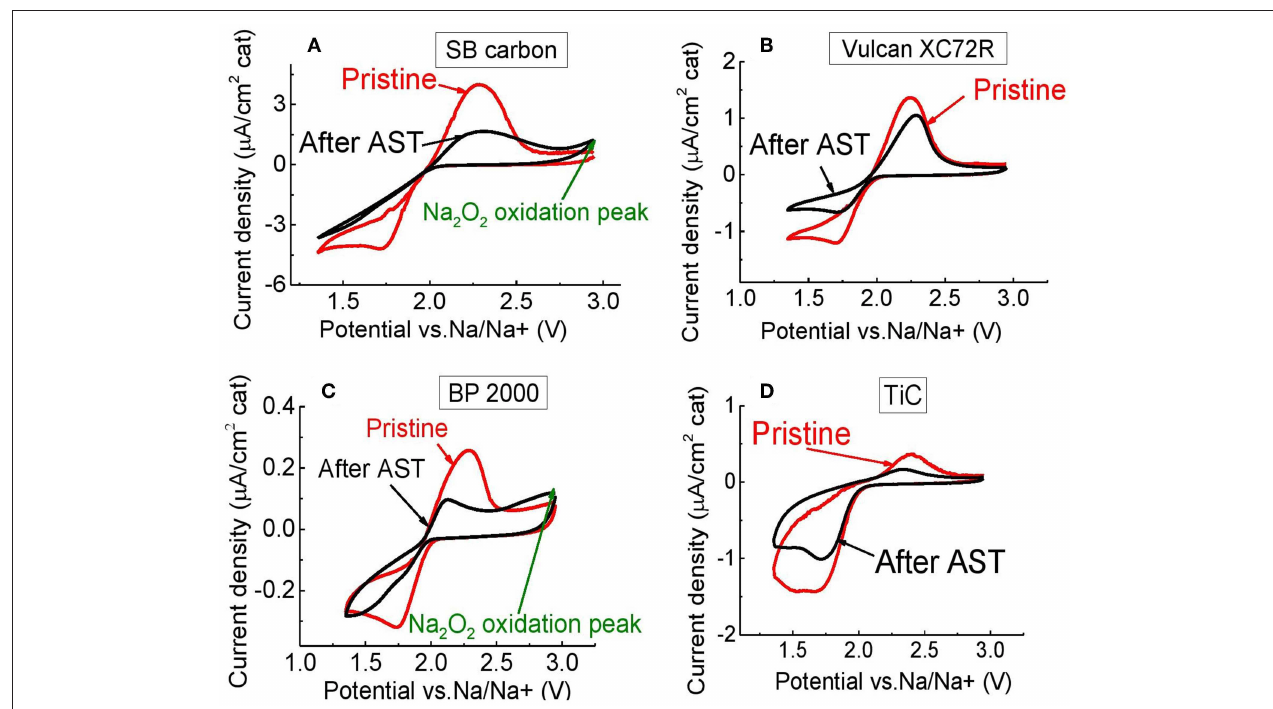
FIGURE 13 | Electrochemical performance of (A) SB carbon, (B) Vulcan XC72R, (C) BP 2000, (D) TiC, before and after durability test, in PEGDME/0.25M NaOTf (Scan rate 5